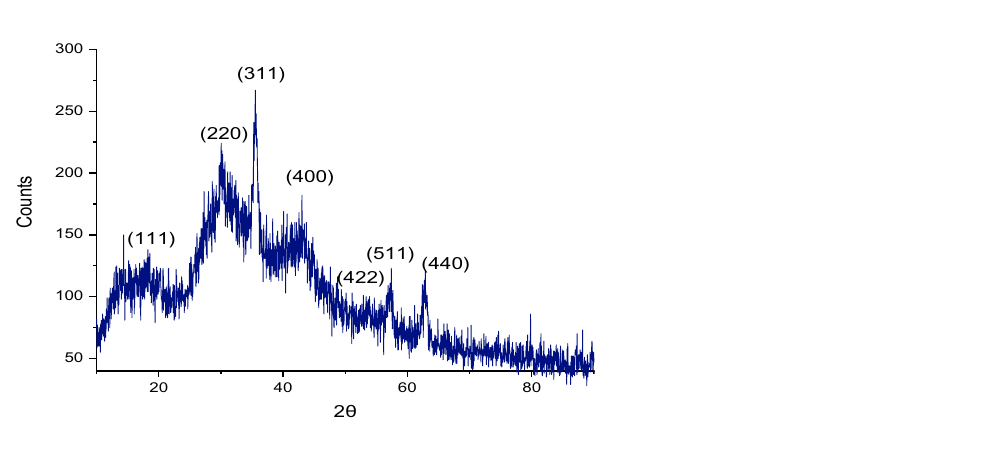
Figure 7. XRD pattern of Fe 3 O 4 @SiO 2